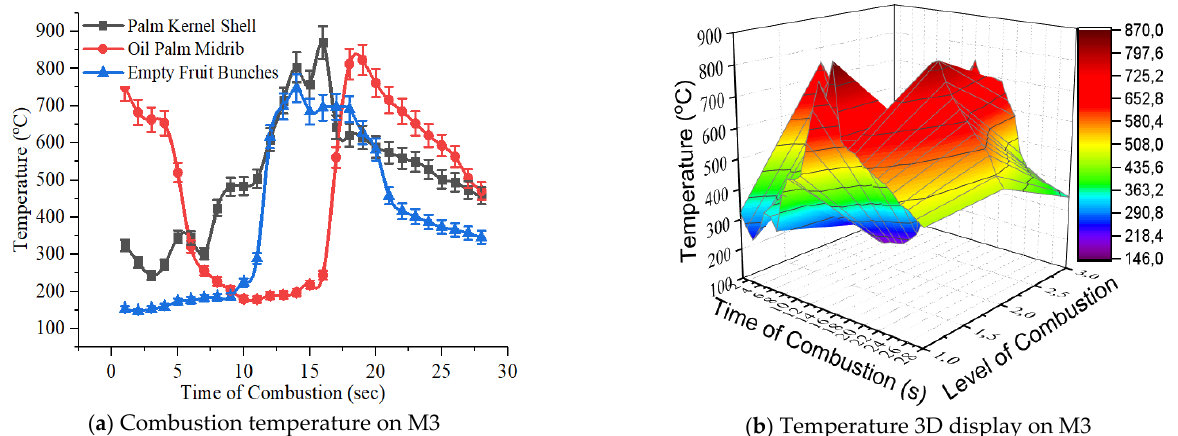
Figure 6. Combustion temperature measurement of M3 at different times and fuels.